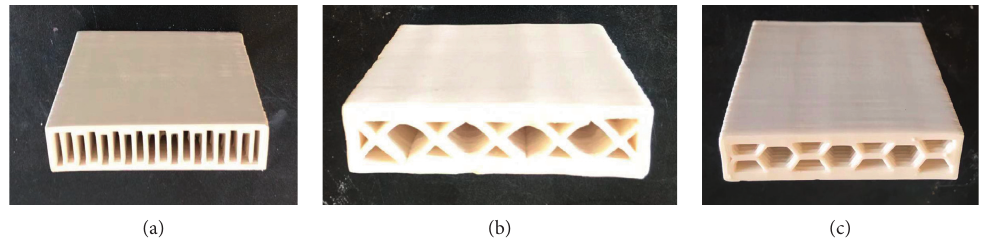
Figure 2: Printed green bodies: (a) vertical supporting structure, (b) oblique square grid supporting structure, and (c) honeycomb grid supporting structure.